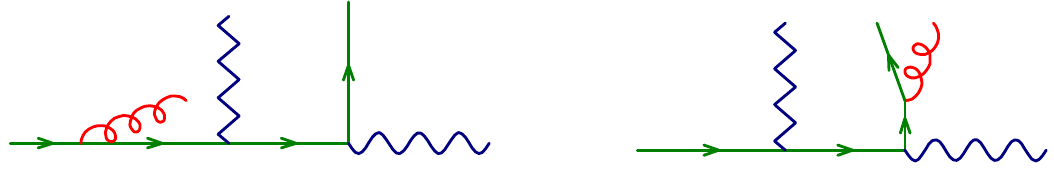
Figure 8 . Singularities in the λ → 0 limit. The diagram on the left contributes a collinear initial state singularity, and a soft singularity. The diagram on the right contributes a final state collinear singularity, and a soft